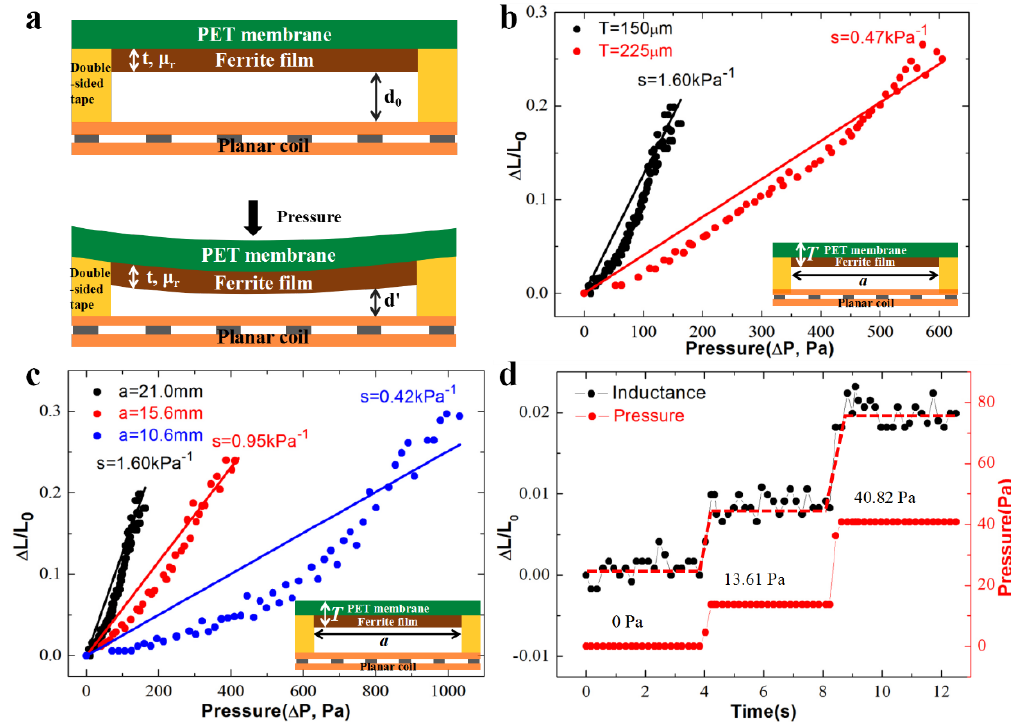
Figure 3. ( a ) Schematic diagram of operation principle of the inductance pressure sensor in a cross-sectional view; ( b ) experimental and theoretical investigations on the device sensitivity as the thickness of the polyethylene terephthalate (PET)/ferrite film T varying from 150 to 225 μm and ( c ) the edge length of the ferrite film a changing from 10.6, 15.6 to 21.0 mm. The measurement results (dots) are plotted against the theoretical predictions (solid lines) from Equation (2); ( d ) the inductance responses to an incremental pressure from 0 to 40.8 Pa.